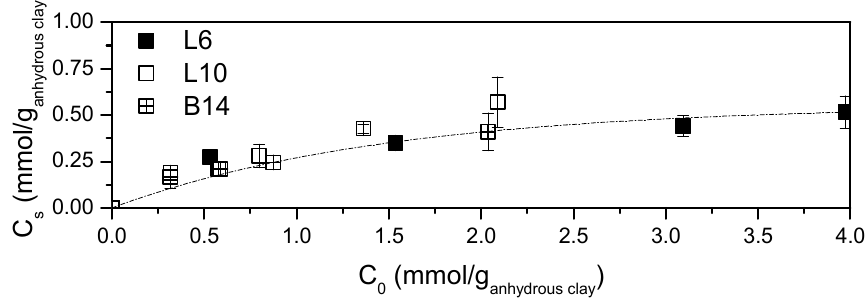
Figure 2. Amine content in the solids as a function of the initial contacted amine.